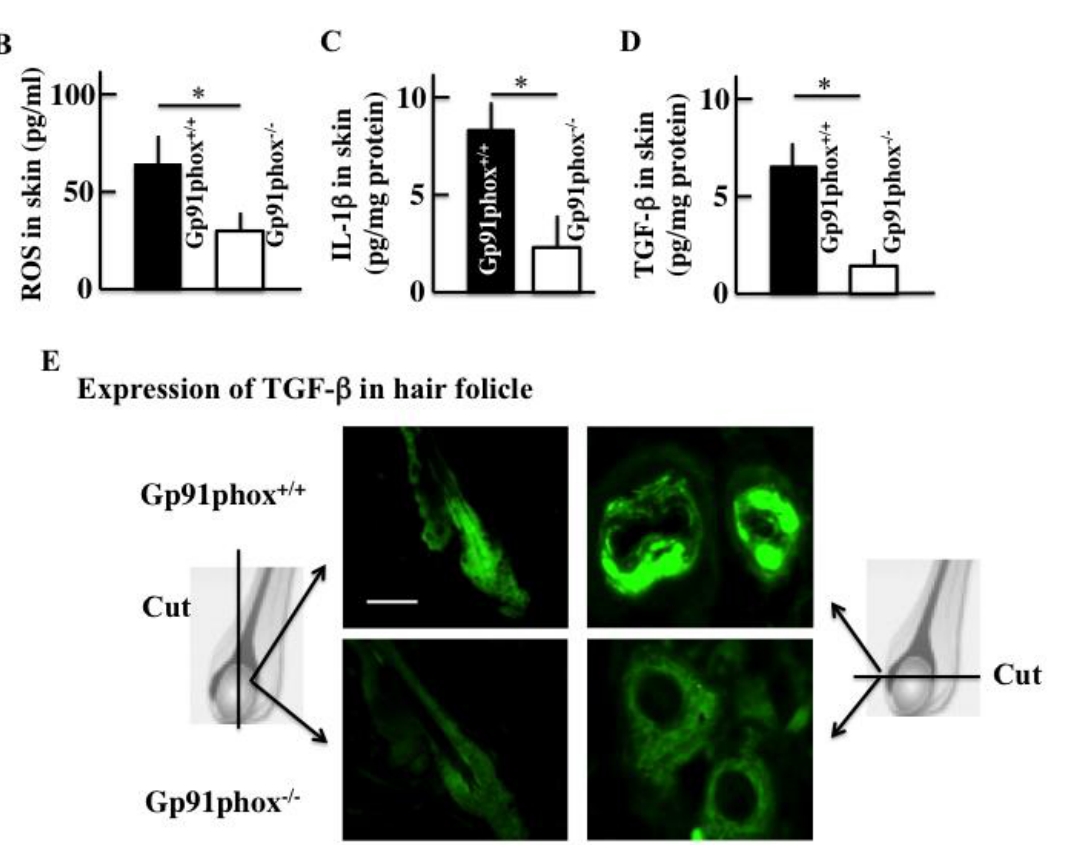
Figure 1. The color of hair on the dorsal skin in twelve-months-old gp91phox −/− mice ( A ). An analysis of the skin ROS ( B ), IL-1 β ( C ), and TGF- β ( D ) concentrations in twelve-month-old gp91phox − / − mice. The expression levels of TGF- β in the niche of hair follicle in dorsal skin of the gp91phox − / − mice at twelve-months old ( E ). The data show the results from one typical experiment involving six animals. The values are expressed as mean ± standard deviation (SD) derived from six animals. * p < 0.05. Scale bar = 10 μm.